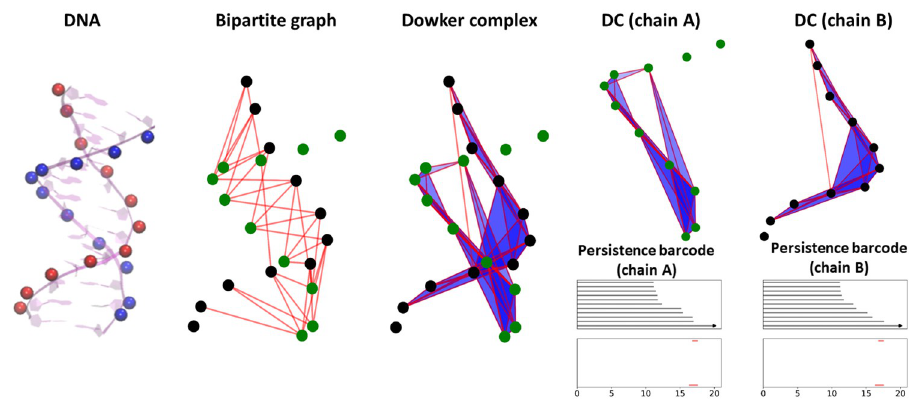
Fig 1. Dowker complex based representation for the atomic interactions between two chains of DNA 1D77. Only the Phosphor (P) atoms of the DNA are considered. A bipartite graph is constructed between the two DNA chains, i.e., chain A and chain B, using a cutoff distance of 16.5 Å . The corresponding Dowker complex is generated and consists of two disjoint components, one from chain A and the other from chain B. The cutoff distance can be used a filtration parameter and two persistent barcodes are obtained. It can be seen that the β 1 persistent barcodes are exactly the same for the two types of DCs from chain A and chain B. The β 0 persistent barcodes are different because the bipartite graph are not always connected during the filtration